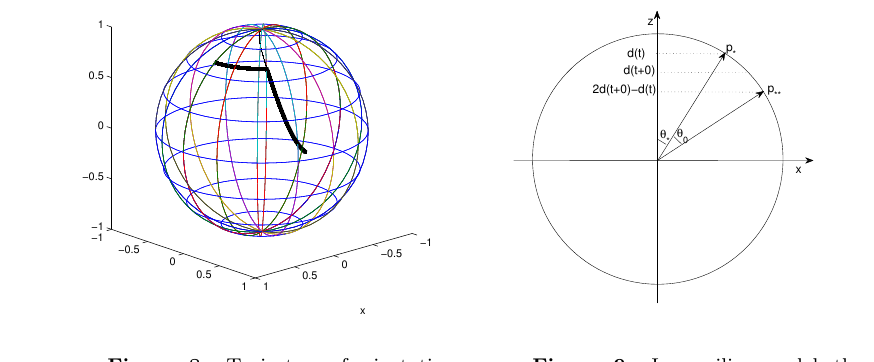
Figure 8. Trajectory of orientation vector, sliding model.